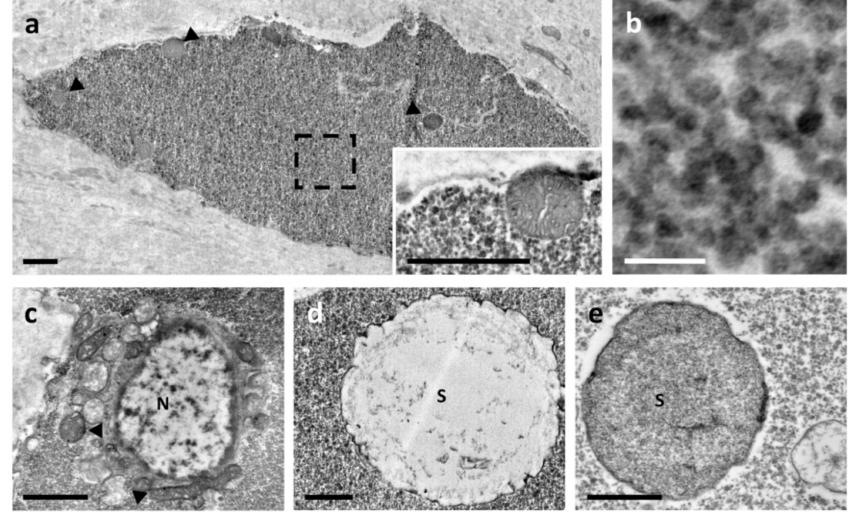
Figure 4. Electron micrography of cells with cytoplasmic spheres. ( a ) Cell with some spheres embedded in cytoplasm. Scale bar = 1 µ m. ( b ) Magnification of the zone marked in (a) showing that the cytoplasm was full of globular structures of low electron density. Scale bar = 100 nm. ( c , d ) Nucleus (N), mitochondria (arrowheads), Golgi apparatus (G), electron-dense granules (arrows) and some vacuoles (V) were visible close to cell plasma membrane. Scale bar = 1 µ m and the enlargement scale bar = 250